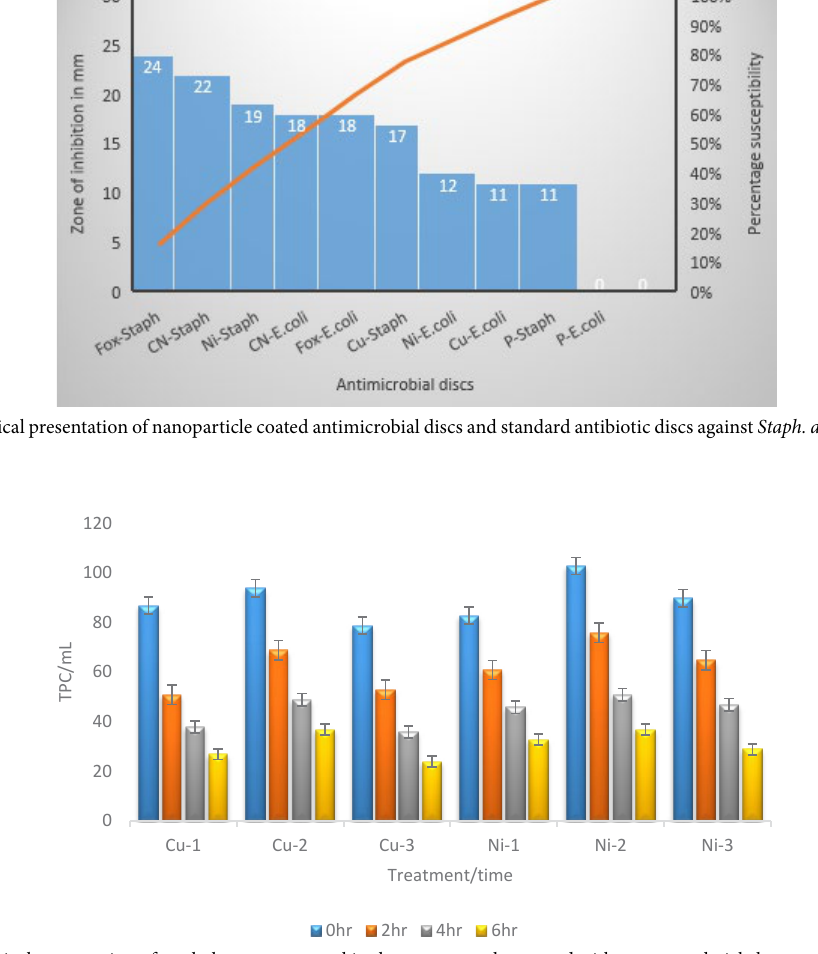
Fig. 12. Graphical presentation of total plate count per ml in the water samples treated with copper and nickel nanoparticles for